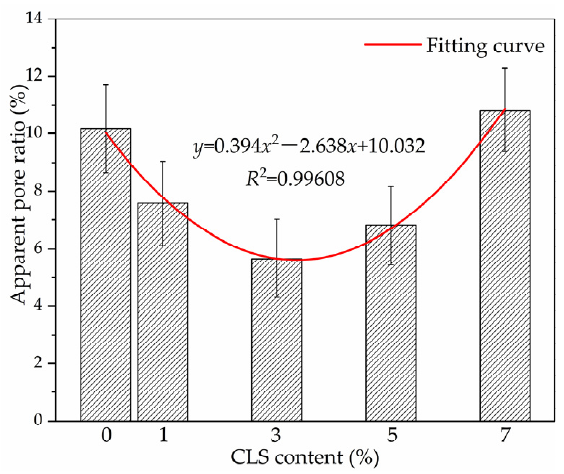
Figure 14. Apparent pore ratio of improved loess with different CLS content.